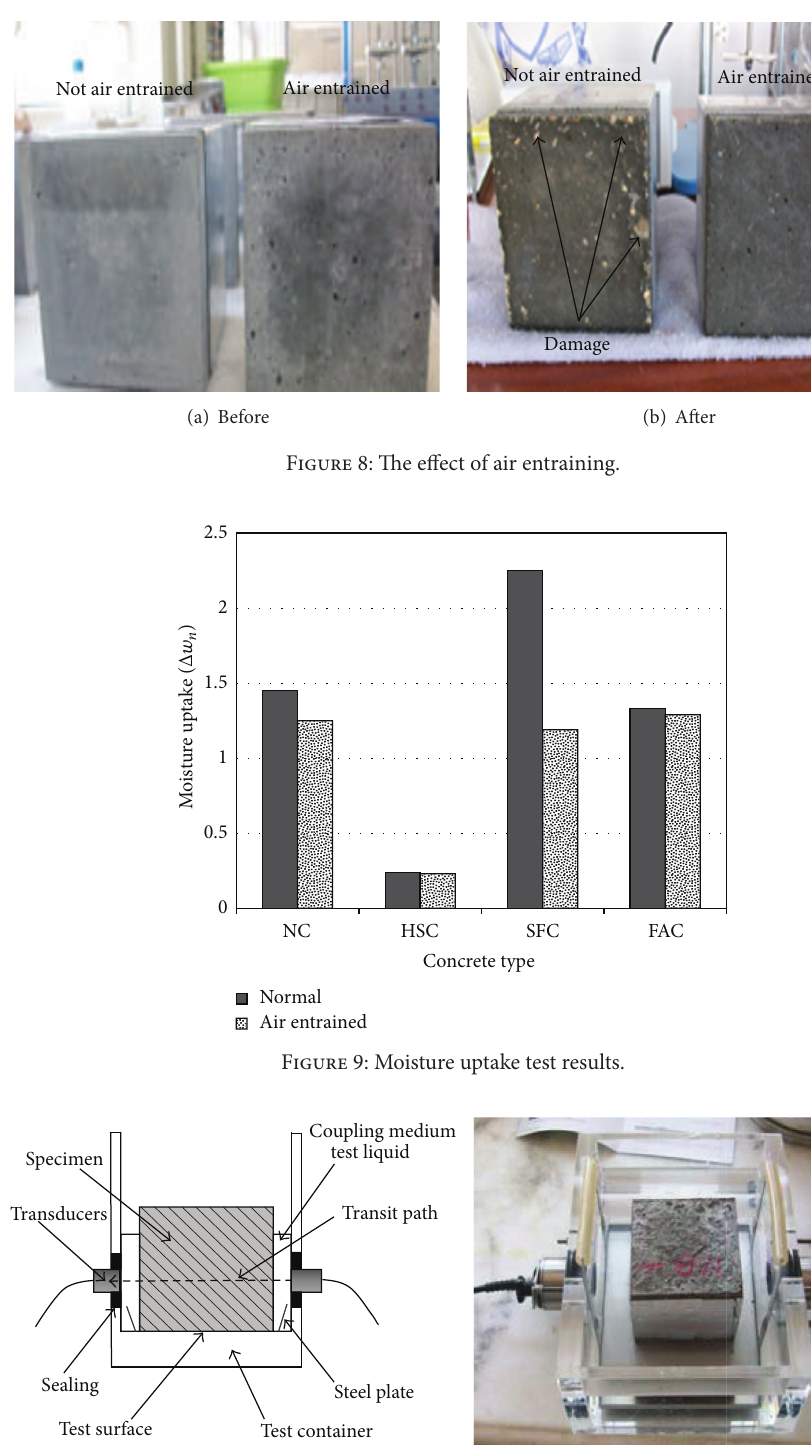
Figure 10: Ultrasound transit time